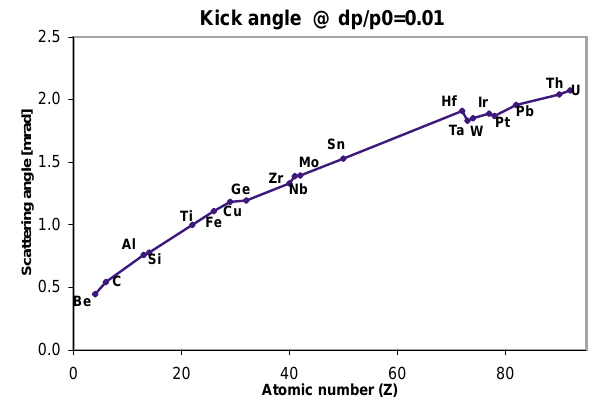
FIG. 4. (Color) Average scattering angle for different materials. The length of the target has been fitted so as to produce an ionization energy loss of 1% of the initial